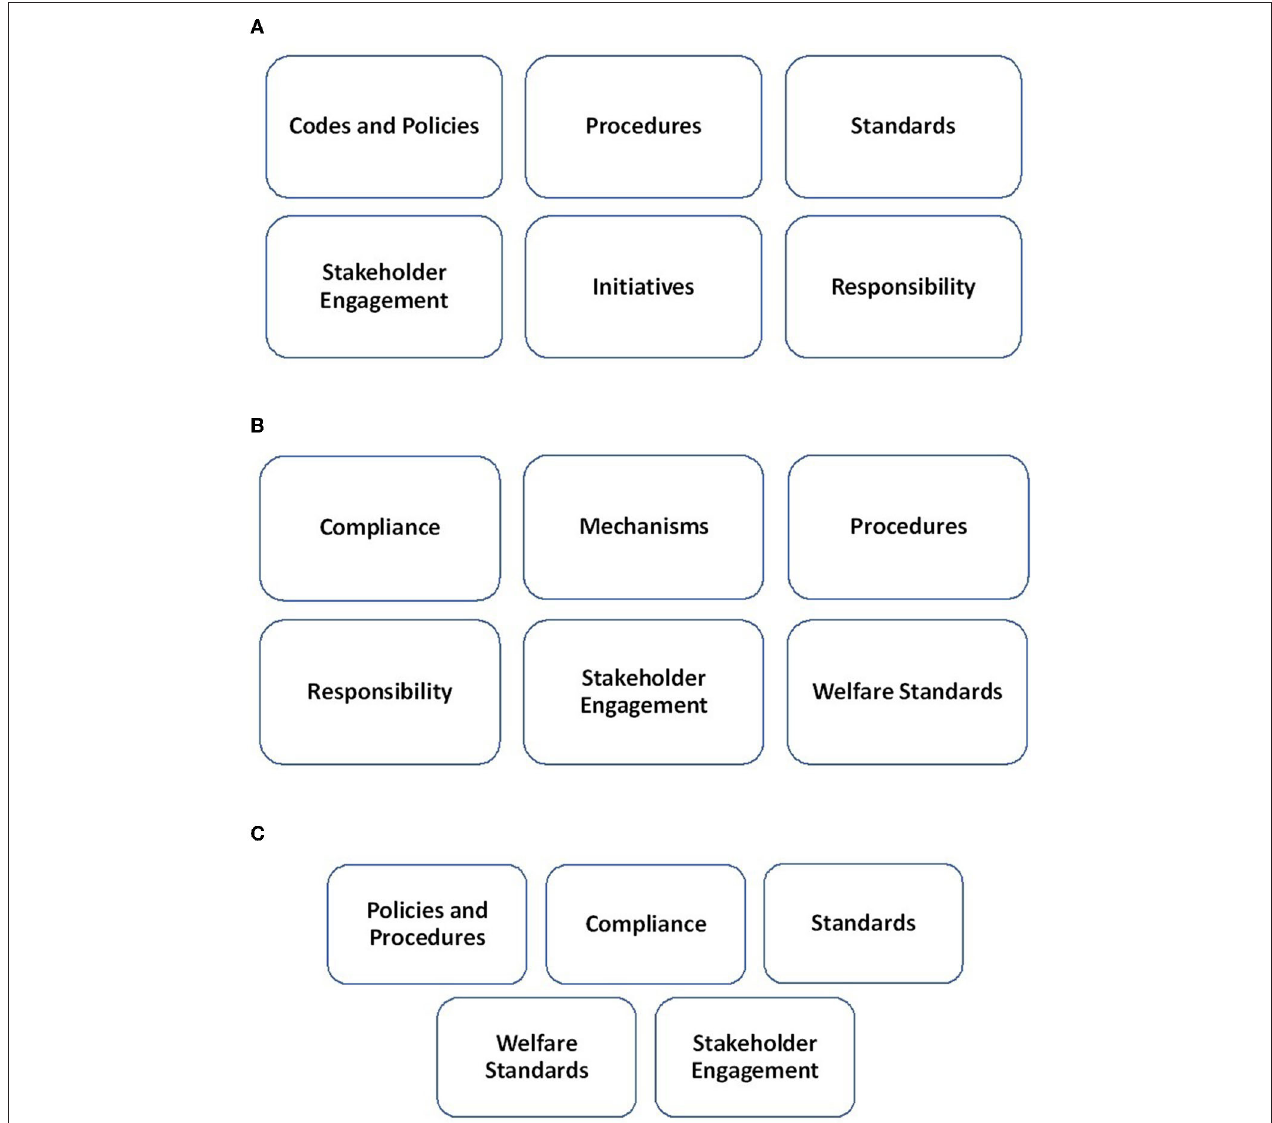
FIGURE 2 | (A) FIFA human rights pillars. (B) The SC human rights pillars. (C) Q22 Human rights